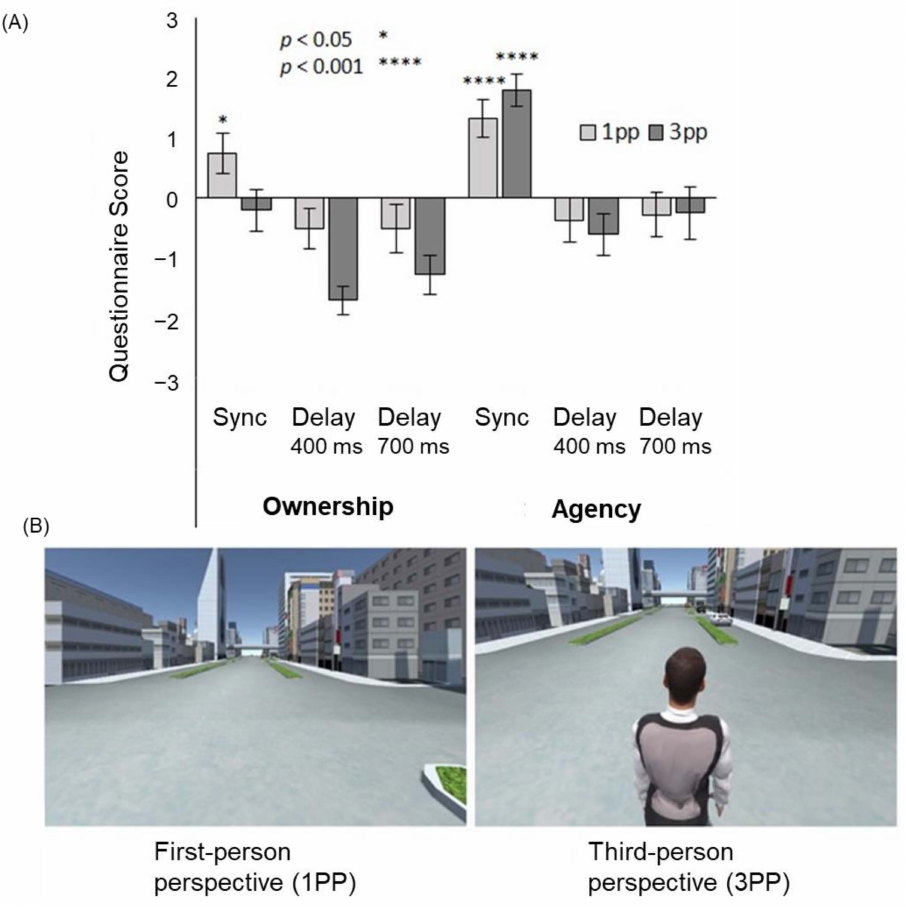
Figure 5. Full-body illusion from the first- and third-person perspective. ( A ) The sense of ownership was felt only in the synchronous first-person perspective (1PP) condition, while the sense of agency was felt in the synchronous 1PP and third-person perspective (3PP) conditions. ( B ) Examples of a VR scene presented to the participants